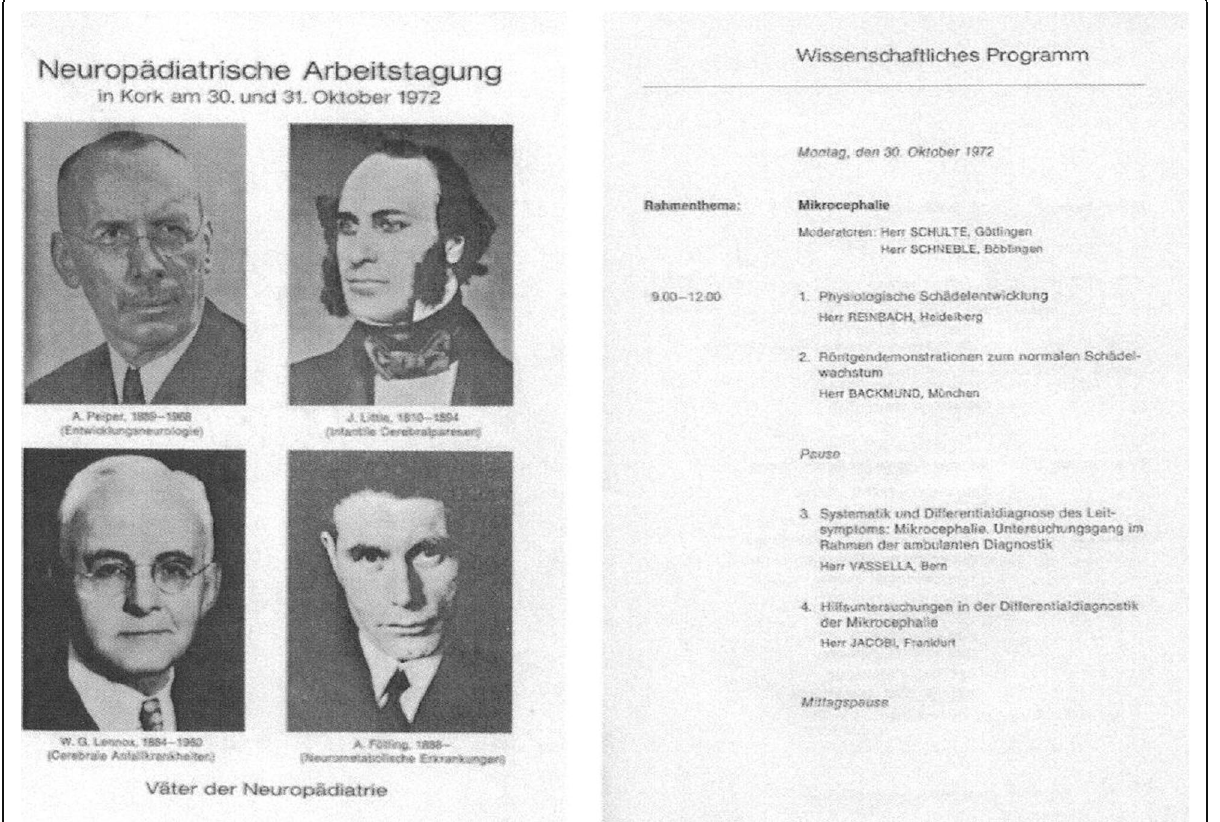
Fig. 4 The first pages of the Neuropediatic workshop program in Kehl-Kork 1972